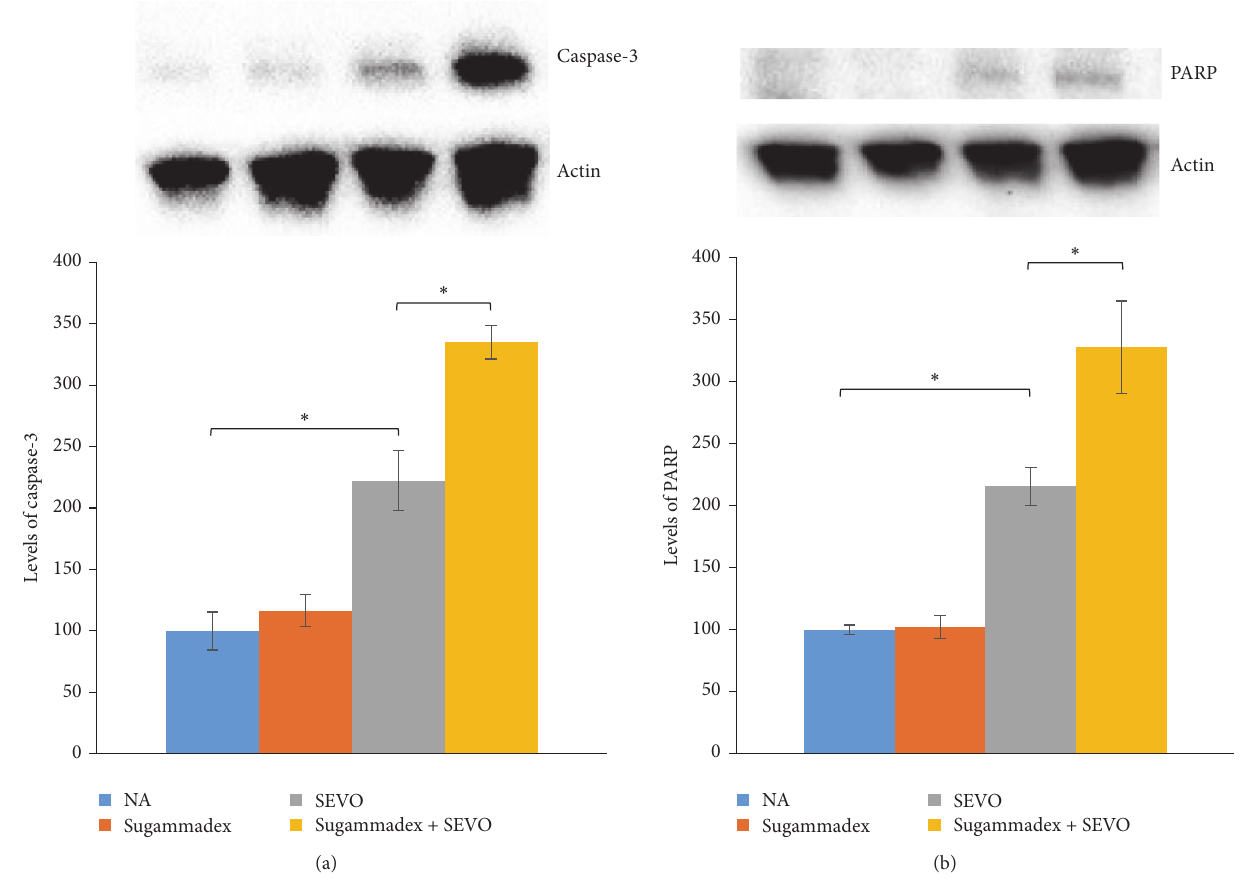
Figure 2: Apoptosis in the forebrain was evaluated by (a) cleaved caspase-3 and (b) cleaved PARP activation in each group after 6h of sevoflurane exposure. Exposure to sevoflurane for 6 h increased neuronal apoptosis compared to the control group. Coadministration of sugammadex significantly exacerbated neuronal apoptosis induced by sevoflurane exposure. Sugammadex alone did not cause apoptosis ( ∗ 𝑃 < 0.05 , 𝑛 = 8